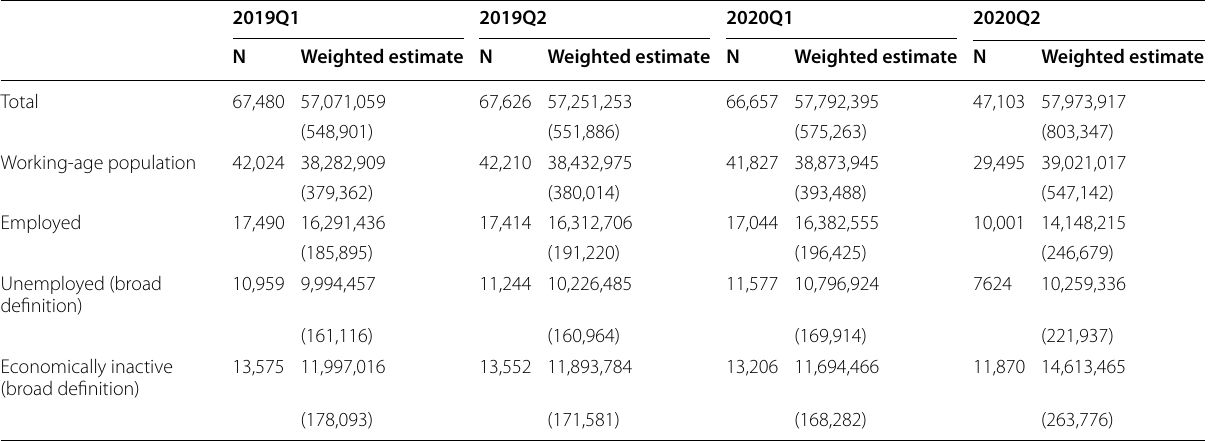
This table presents, for each quarter in the data, sample sizes (N) and weighted population estimates of given groups of individuals by year and quarter (Q). Relevant estimates weighted using sampling weights. Labour market groups restricted to the working age (15–64 years). Standard errors presented in parentheses and